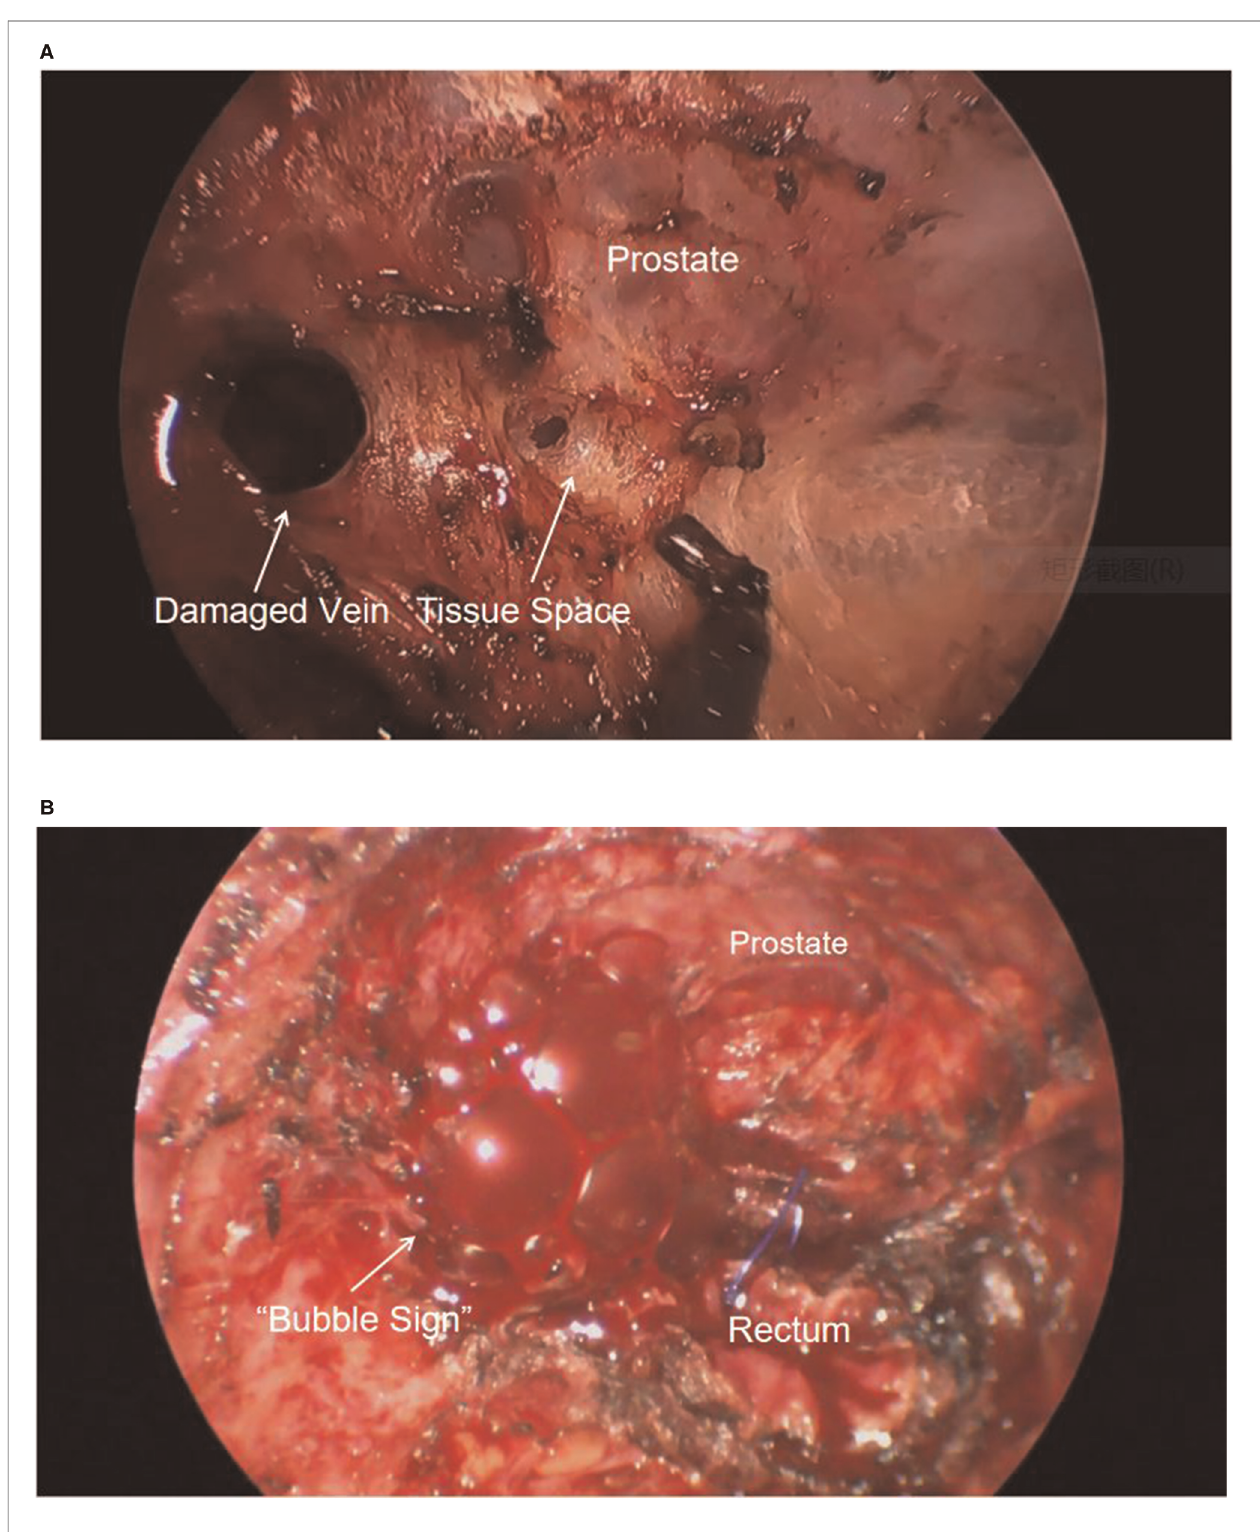
FIGURE 1 | ( A ) Damaged veins remain open under the pneumopelvis. ( B ) “ Bubble sign ” after carbon dioxide enters the damaged